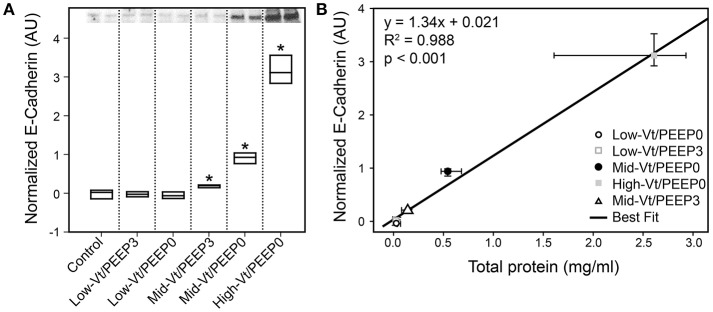
Epithelial damage marker soluble E-Cadherin content in bronchoalveolar lavage fluid (BALF). (A) The 85 kDa E-Cadherin level is normalized to the control group; Mid-Vt/PEEP0, Mid-Vt/PEEP3, and High-Vt/PEEP0 are significantly different from all other groups (*). (B) BALF E-Cadherin is linearly related to BALF total protein (R2 = 0.996). Data points show the median with error bars indicating the interquartile range.